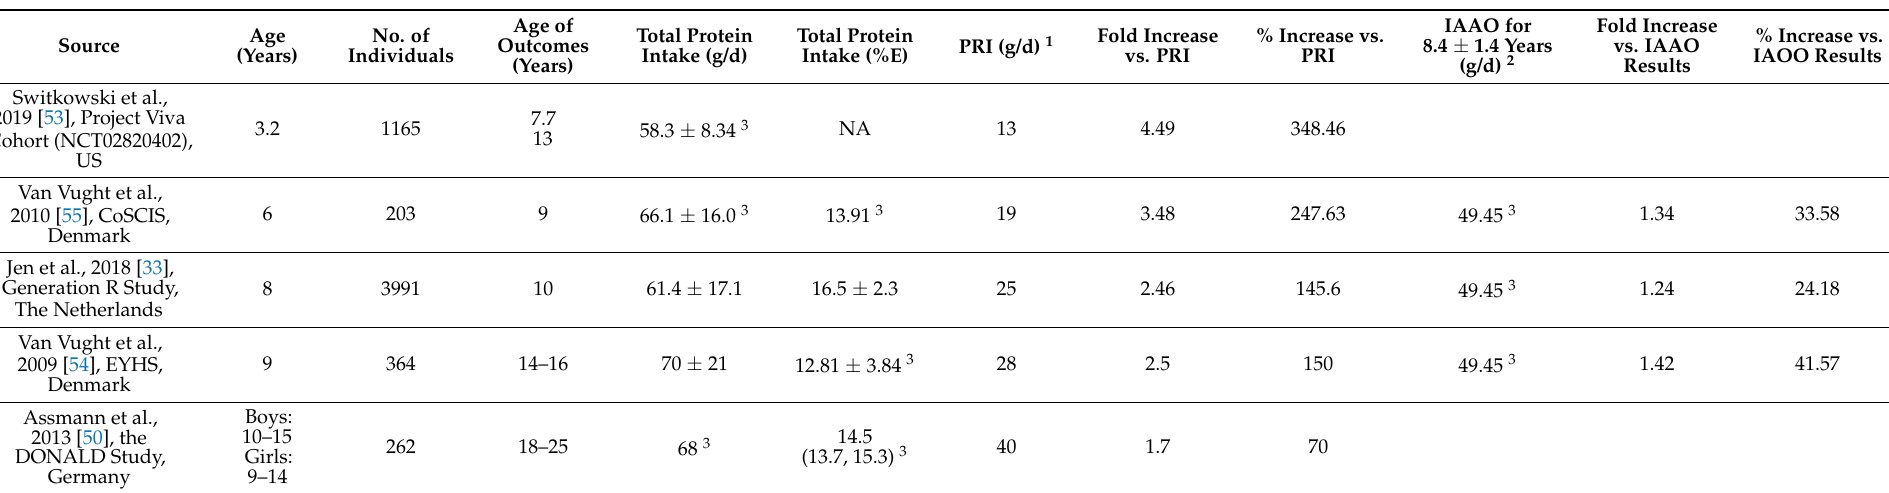
Table 4. Comparison of the increase in protein intake with respect to PRI and IAAO